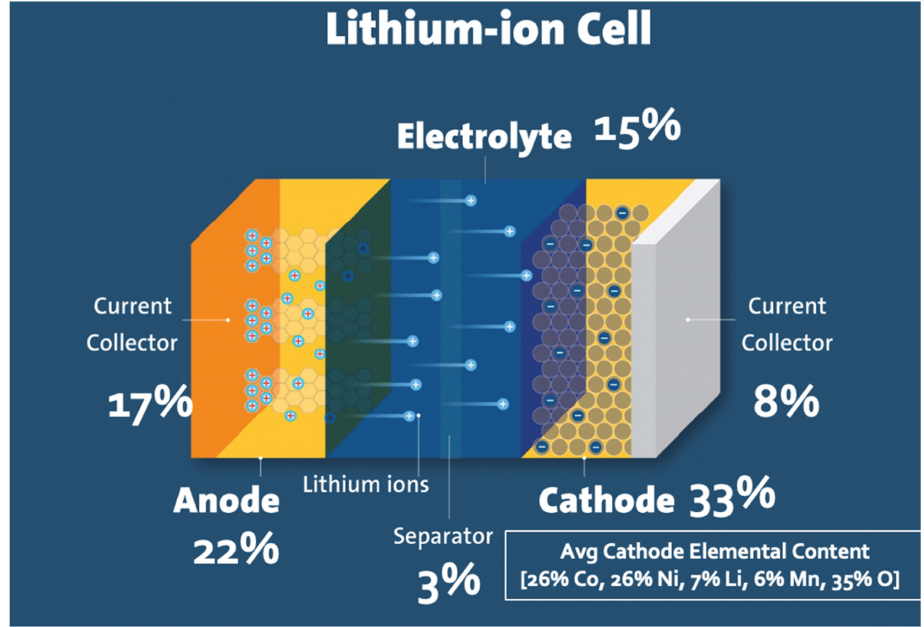
Figure 5. Typical Li-ion battery composition (data derived from [17,18,21]).